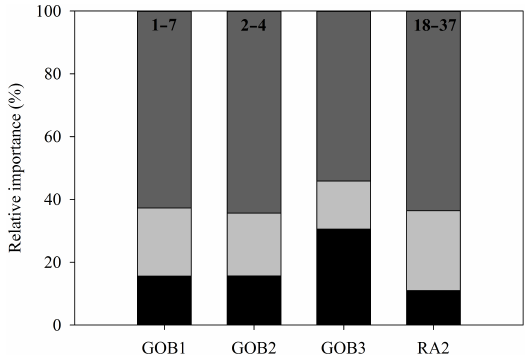
Figure 7. Relative importance in percentage of sediment burial (black bars), N 2 production (light grey bars), and TDN efflux (dark grey bars) as N sink and source at the four stations. Range values represent the contribution (%) of DNRA to the TDN efflux. Pro- cesses are expressed on a molar (N) scale. See text for